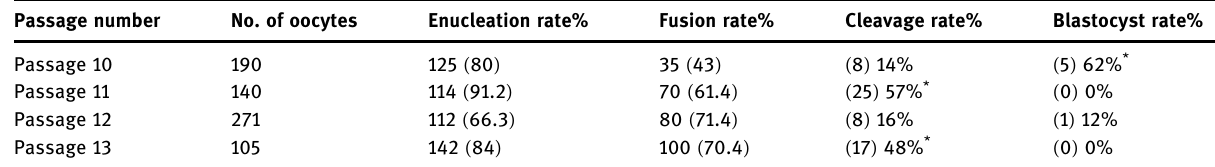
*Signi fi cant di ff erence at p < 0.01 compared to the others without star at the same type of passage or